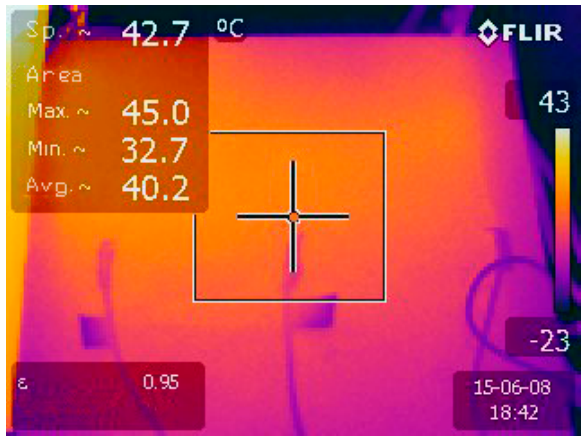
Figure 3. Specimen temperature controlled with an IR camera.